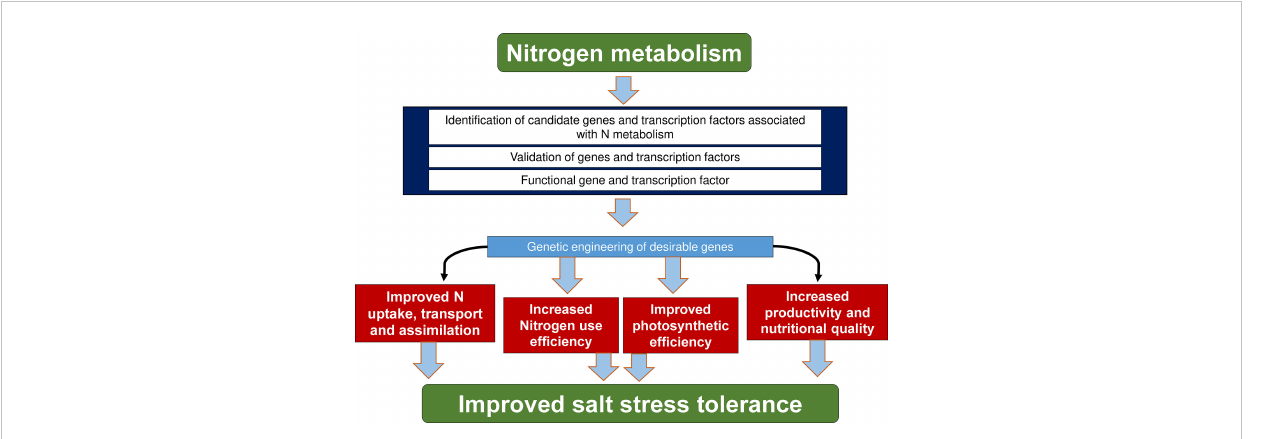
FIGURE 4 Speci fi c targets for manipulating nitrogen dynamics through genetic engineering. Nitrogen dynamics is mainly associated with higher expression of nitrate and ammonium transporter genes as well as transcription factors, and the overexpression of these genes in transgenic plants leads to increased nitrogen use ef fi ciency, photosynthesis, crop productivity and nutritional quality, nitrate and ammonium uptake and salt-stress